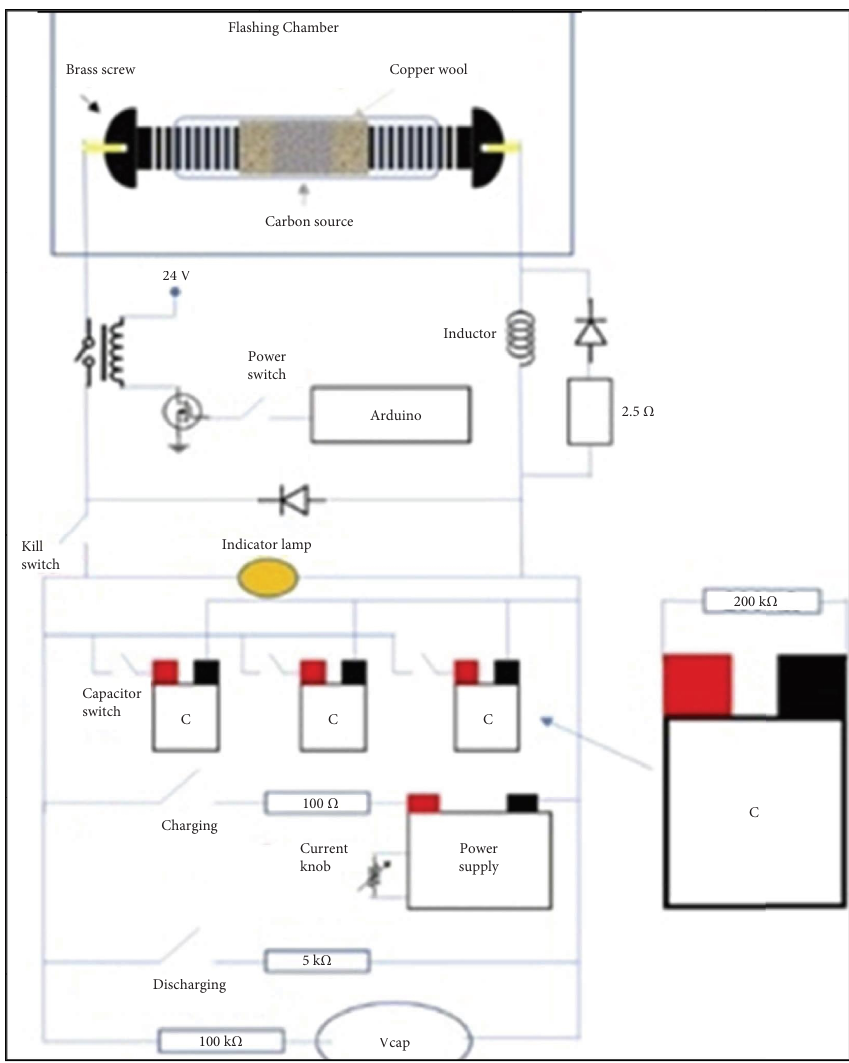
Figure 20: Electrical circuitry for FJH graphene